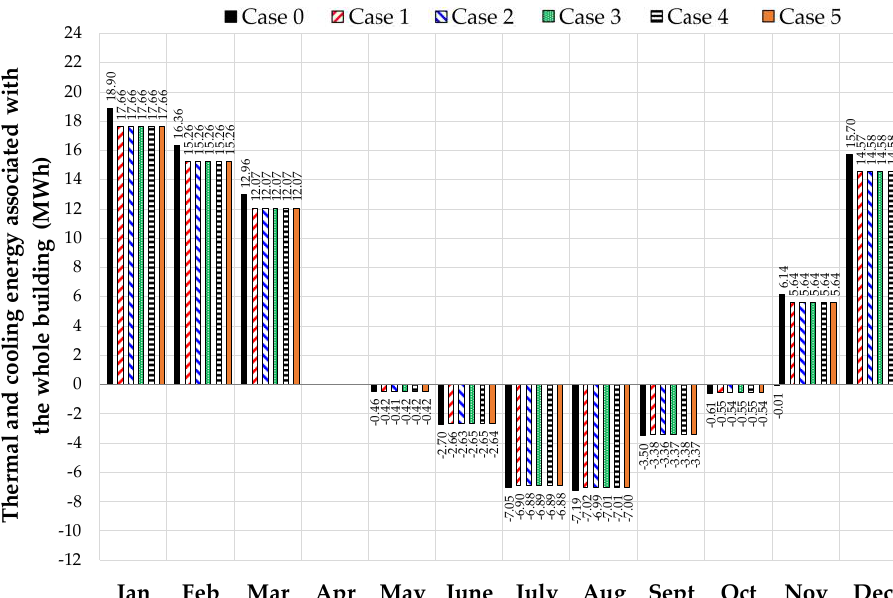
Figure 14. Values of PES upon varying the case studies.